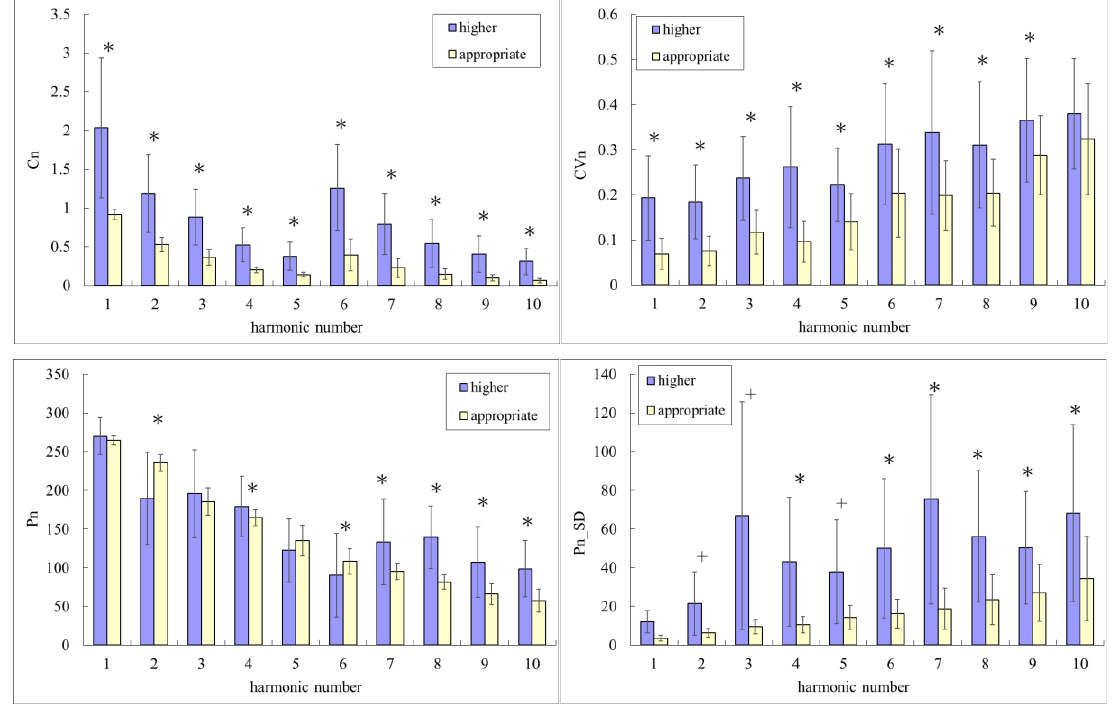
Figure 3. Comparisons of harmonic indices between applying the appropriate and higher contact pressures: C n , CV n , P n , and P n _ SD . Data are mean and standard-deviation values. C 6 – C 10 values have been multiplied by 10 to make the differences clearer. “*” indicates p < 0.05; “ + ” indicates 0.05 < p <